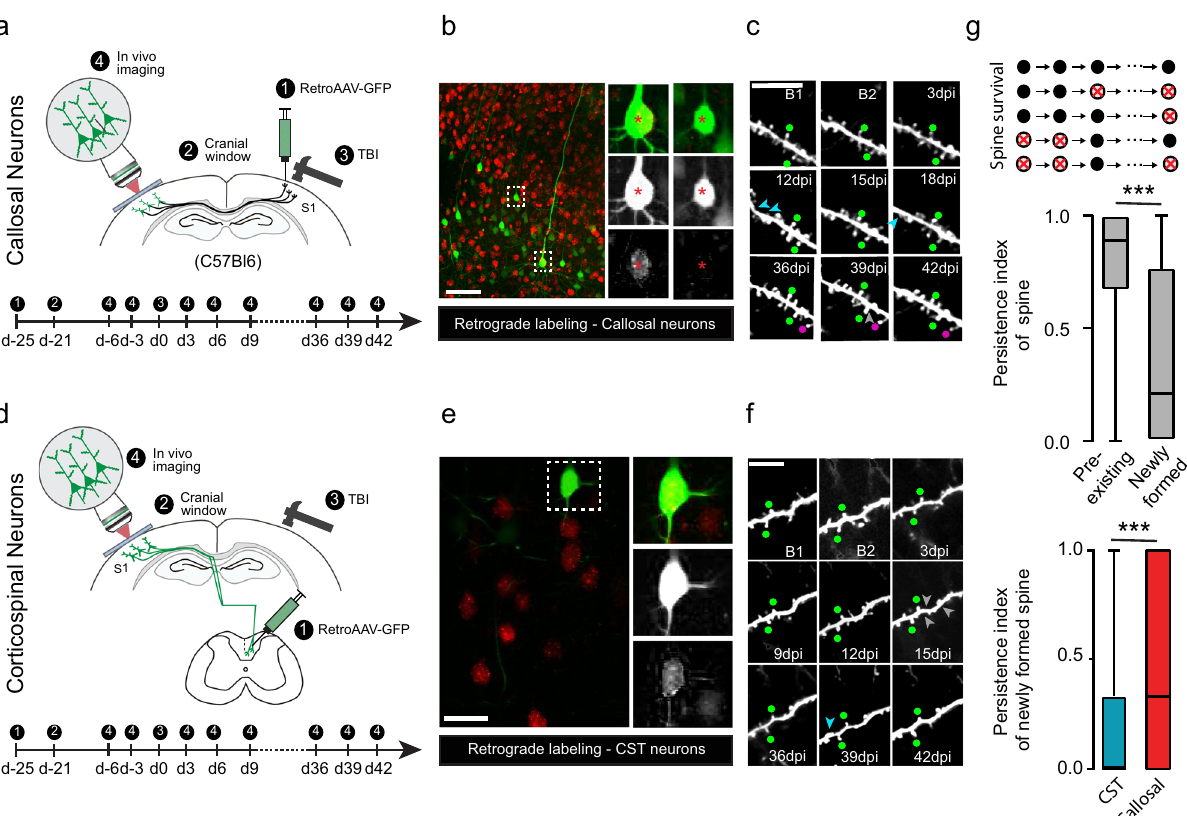
Fig. 4 Differential stability of newly generated spines formed on callosal and non callosal neurons following traumatic brain injury. a Scheme of the experimental design with retroAAV injected in the lesion area and timeline of the two-photon in vivo imaging. b Confocal images of retrogradely labeled callosal neurons in the cortex (Green: retroAAV-EGFP; red: NT435). Insets are four times magni fi ed (top raw overlay; middle raw: retroAAV-EGFP; bottom raw: NT435).Scale bar equals 50 μ m. c Representative timelapse series of an apical dendrite from a callosal neuron retrogradely-labeled with retroAAV- EGFP. Each image shows the same dendrite stretch at a speci fi c experimental time point before and up to 42d post-injury (23 independent dentritic stretches and 8724 spines were followed). Cyan arrowheads indicate disappearing pre-existing spines. Gray arrowheads indicate disappearing newly- formed spines. Green dot indicate stable pre-existing spines. Magenta dots indicate stable newly-formed spines. B1: Baseline 1; B2: Baseline 2; Scale bar: 10 μ m. d Scheme of the experimental design with the retroAAV injected in the spinal cord and timeline of the two-photon in vivo imaging. e Confocal images of retrogradely labeled CST neurons in the cortex (Green: retroAAV-EGFP; red: NT435). Insets are two times magni fi ed (top raw overlay; middle raw:retroAAV-EGFP; bottom raw: NT435). Scale bar equals 50 μ m. f Representative timelapse series of an apical dendrite from a CST neuron retrogradely- labeled with retroAAV-EGFP. Each image shows the same dendrite stretch at a speci fi c experimental time point before and up to 42d post-injury (13 independent dentritic stretches and 4376 spines were followed). Cyan arrowheads indicate disappearing pre-existing spines. Gray arrowheads indicate disappearing newly-formed spines. Green dot indicate stable pre-existing spines. Magenta dots indicate stable newly-formed spines. B1: Baseline 1; B2: Baseline 2; Scale bar: 10 μ m. g Quanti fi cations comparing the persistence of all pre-existing spines ( n = 377 spines analyzed) to all newly formed spines ( n = 187 spines analyzed) (top panel) and the persistence of newly formed spines on callosal ( n = 134 spines from nine dentritic stretches from four animals) and CST neurons ( n = 55 spines analyzed from eight dendritic stretches from four animals) (bottom panel). All data (top and bottom) are analyzed using two-tailed Mann – Whitney test ( p < 0.0001 in both cases) and presented as box plots (top panel: Pre-existing spines: minima:0, maxima:1,median = 0.8889; 25% percentile = 0.6667; 75% percentile = 1; newly formed spines: minima:0, maxima:1; median = 0.2111; 25% percentile = 0; 75% percentile = 0.7708 – bottom panel: CST: minima:0, maxima:1, median = 0; 25% percentile = 0; 75% percentile = 0.3333; Callosal: minima:0, maxima:1,median = 0.3333; 25% percentile = 0; 75% percentile = 1) Source data are provided as a Source Data fi